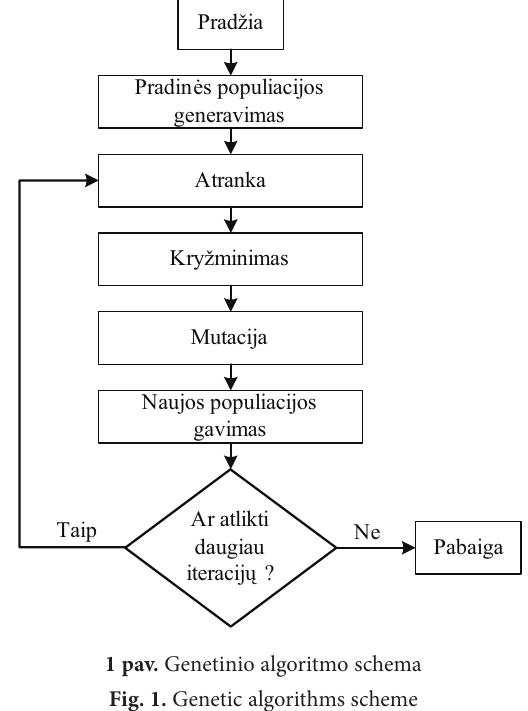
Fig. 1. Genetic algorithms